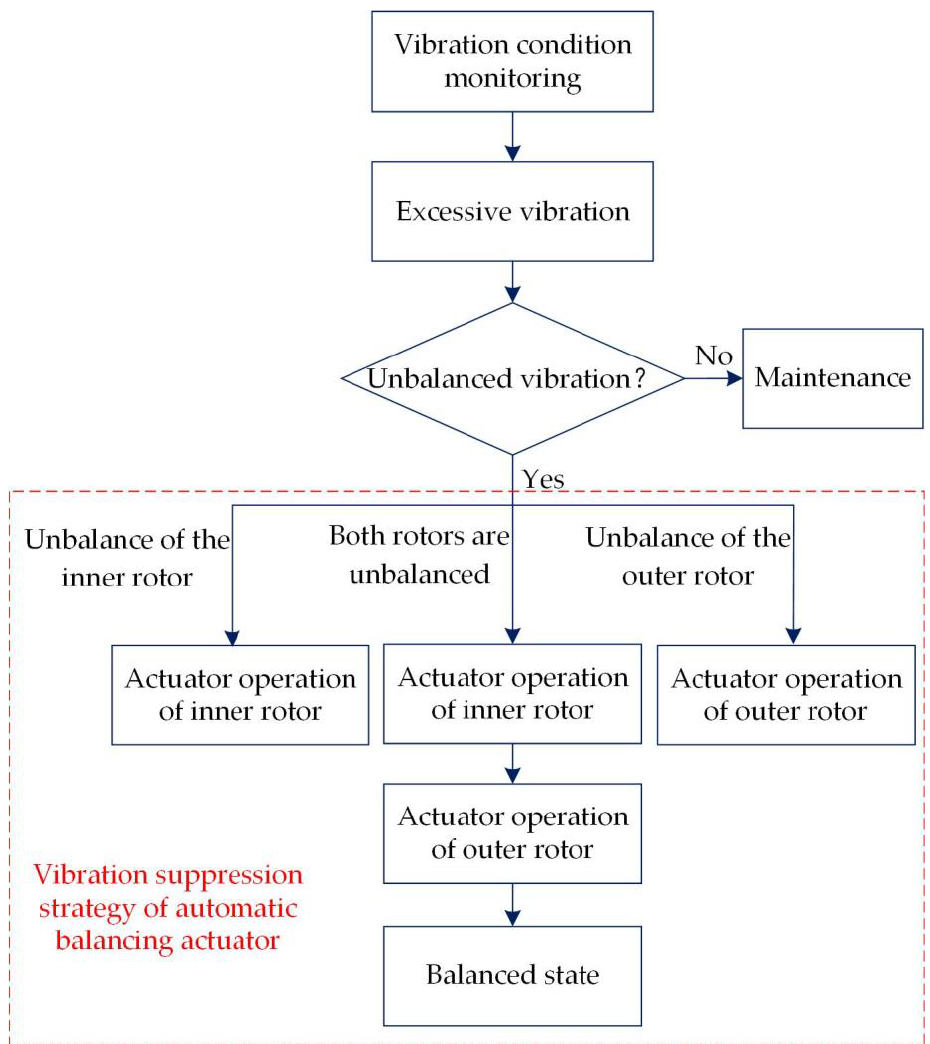
Figure 15. Vibration suppression strategy.